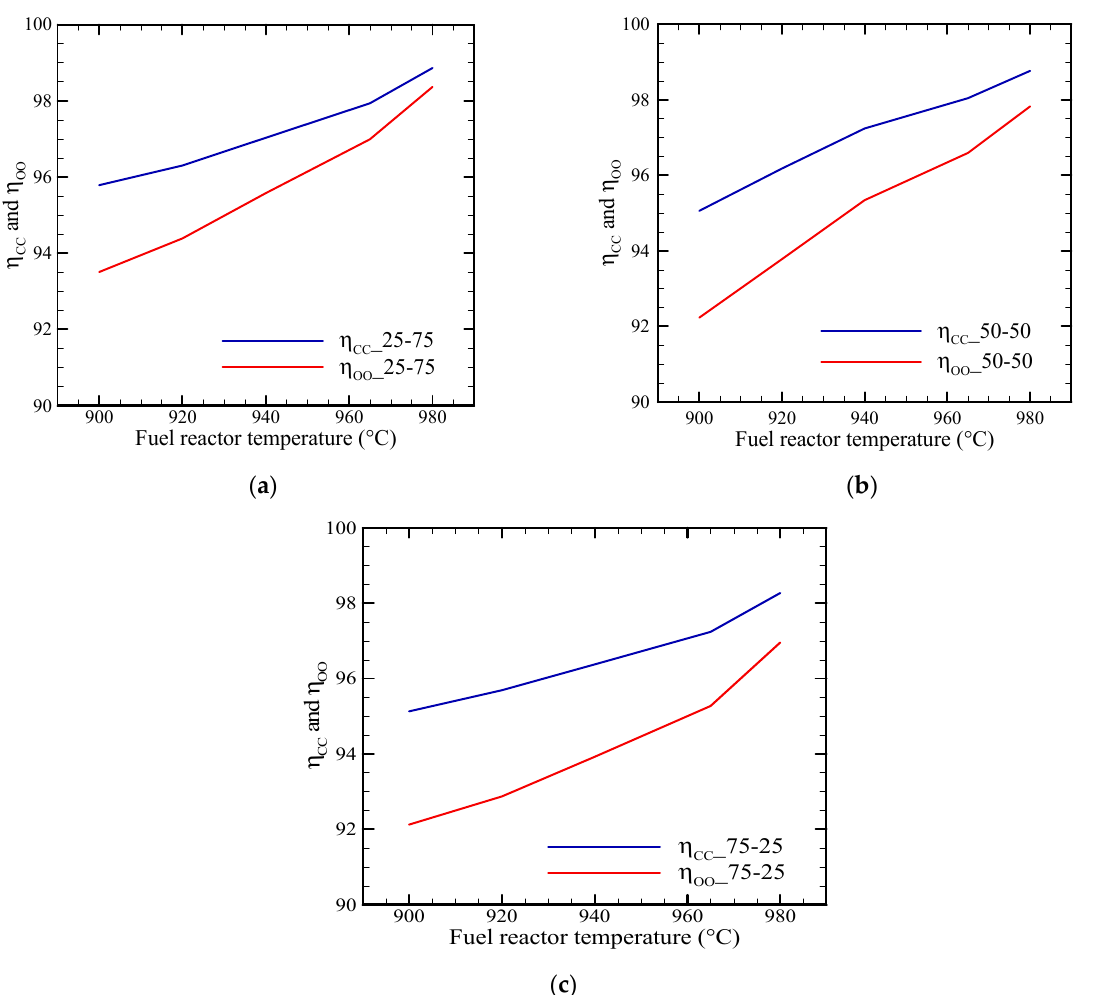
Figure 6. Variations in the oxide oxygen fraction and carbon capture efficiency depending on the temperature of the fuel reactor considering fractions: ( a ) 25/75; ( b ) 50/50; ( c ) 75/25 (% coal/% biomass).